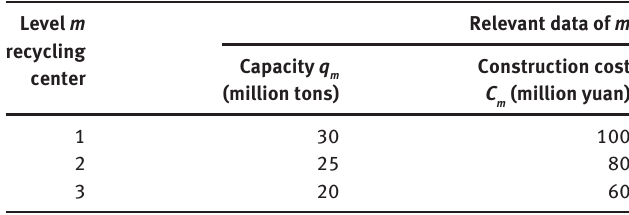
Table 3. Relevant Data of Level m